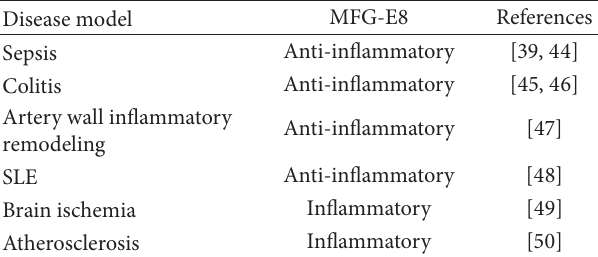
Table 2: MFG-E8 targeting in macrophage-mediated inflamma- tory/autoimmune